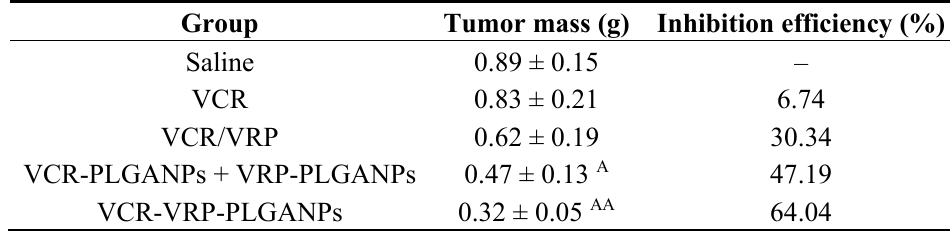
Table 5. The tumor mass of MCF-7/ADR bearing nude mice and the inhibition efficiency after different treatments (Mean ± SD) ( n =